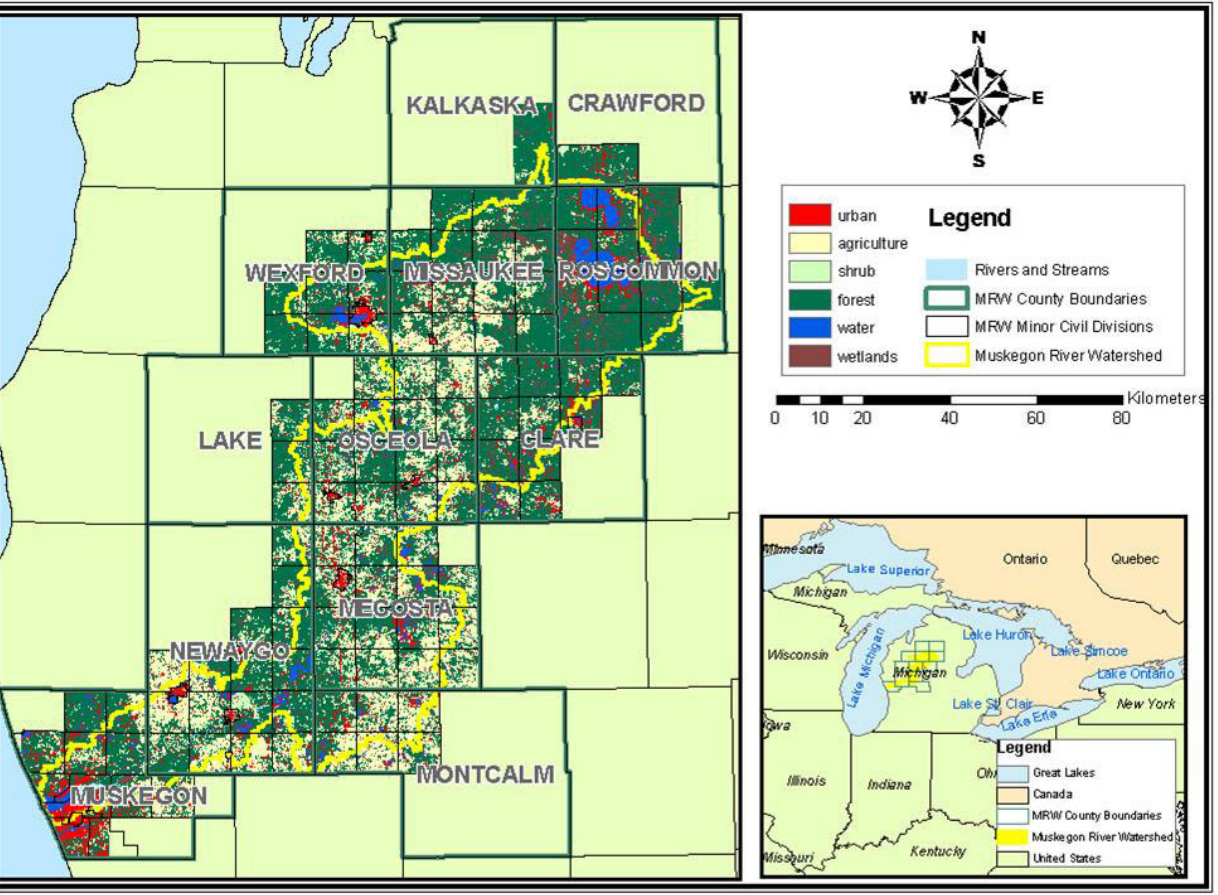
Fig. 1 . Map of the Muskegon River Watershed showing 1998 land use/cover and major hydrologic and political